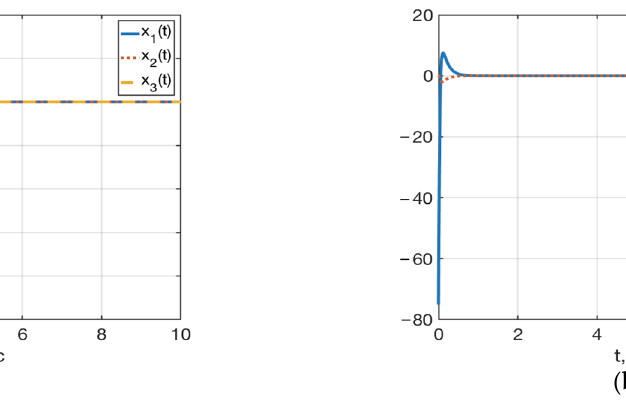
Figure 3. ( a ) Plots of x 1 ( t ) , x 2 ( t ) , x 3 ( t ) ; ( b ) Plots of u 1 ( t ) , u 2 ( t ) in the closed-loop system x = ( 1.1 A + 0.9 BF ) x , (59), (69) with x ( 0 ) = ( 0.5, 0.5, 0.5 ) T . In comparison with system (59), (63) (see Figure 2), the solution norm of the closed- )0( u has increased by about 10 times.